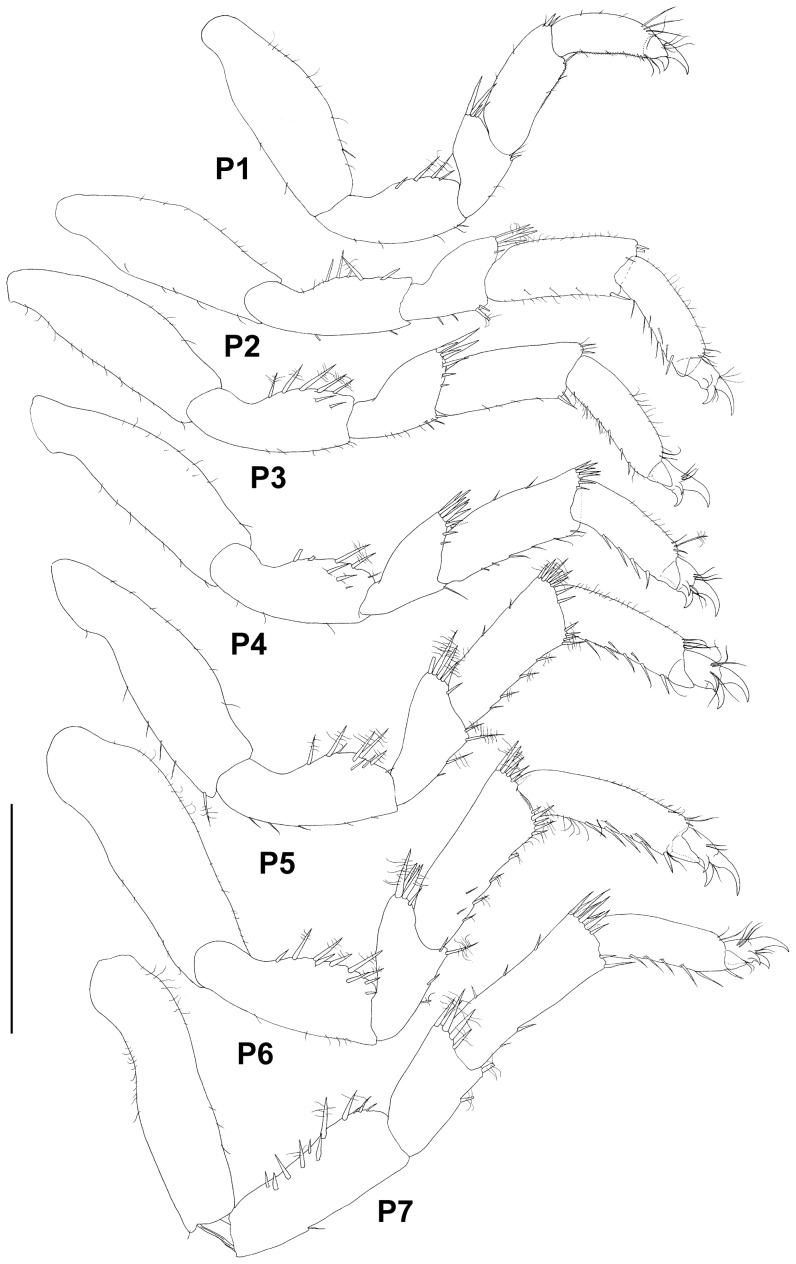
Paratype ZMH K-44089, female, pereopods 1–7, scale – 0.5 mm.